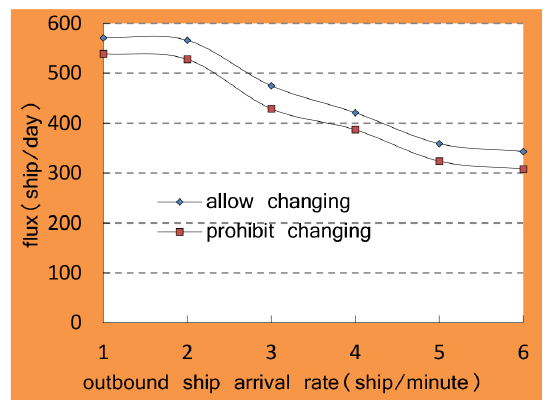
Figure 13. Traffic flux of waterway system and ship arrival rate as a function (inbound ship arrival rate = 2)